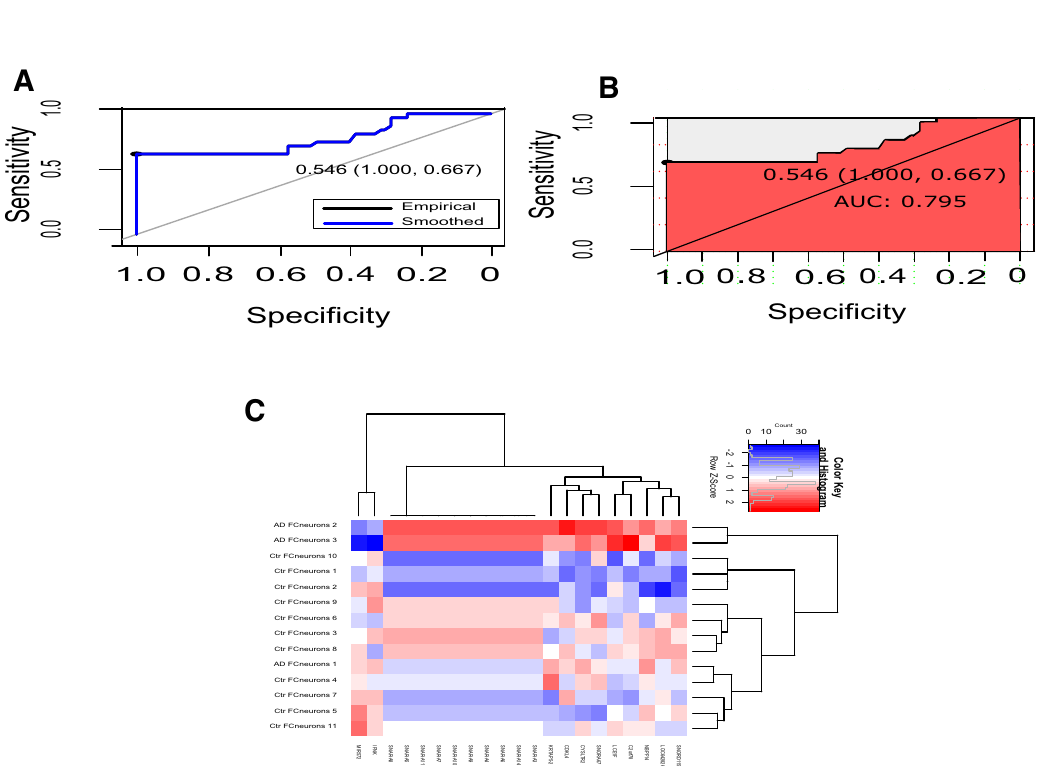
Figure 4. Area under the curve (AUC) result with 2-fold cross-validation and heatmap of gene signature for AD vs control. ( A ) Empirical and smoothed patterns for specificity vs sensitivity plot in AUC. ( B ) AUC plot (AUC value = 0.795 ). ( C ) Heatmap for the cluster 5 (gene signature represented in red color) containing 19 hyper-methylated and 2 hypo-methylated genes for AD vs control, where “AD” and “ctr” on the x-axis stand for Alzheimer’s disease samples and control samples,